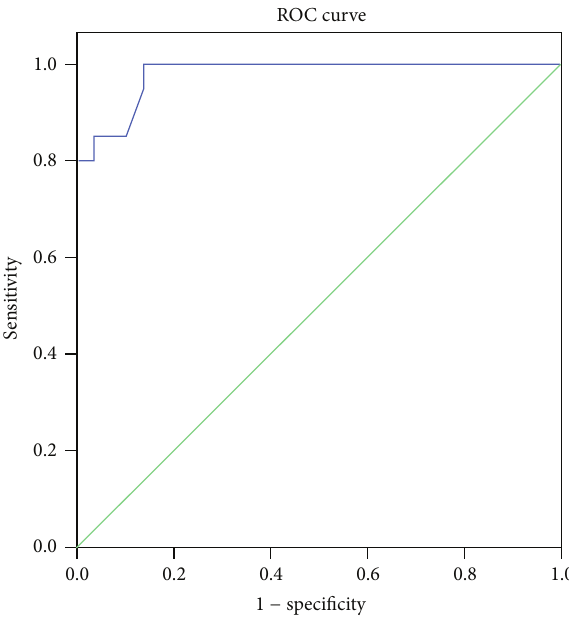
Figure 1: ROC curve for serum ghrelin.